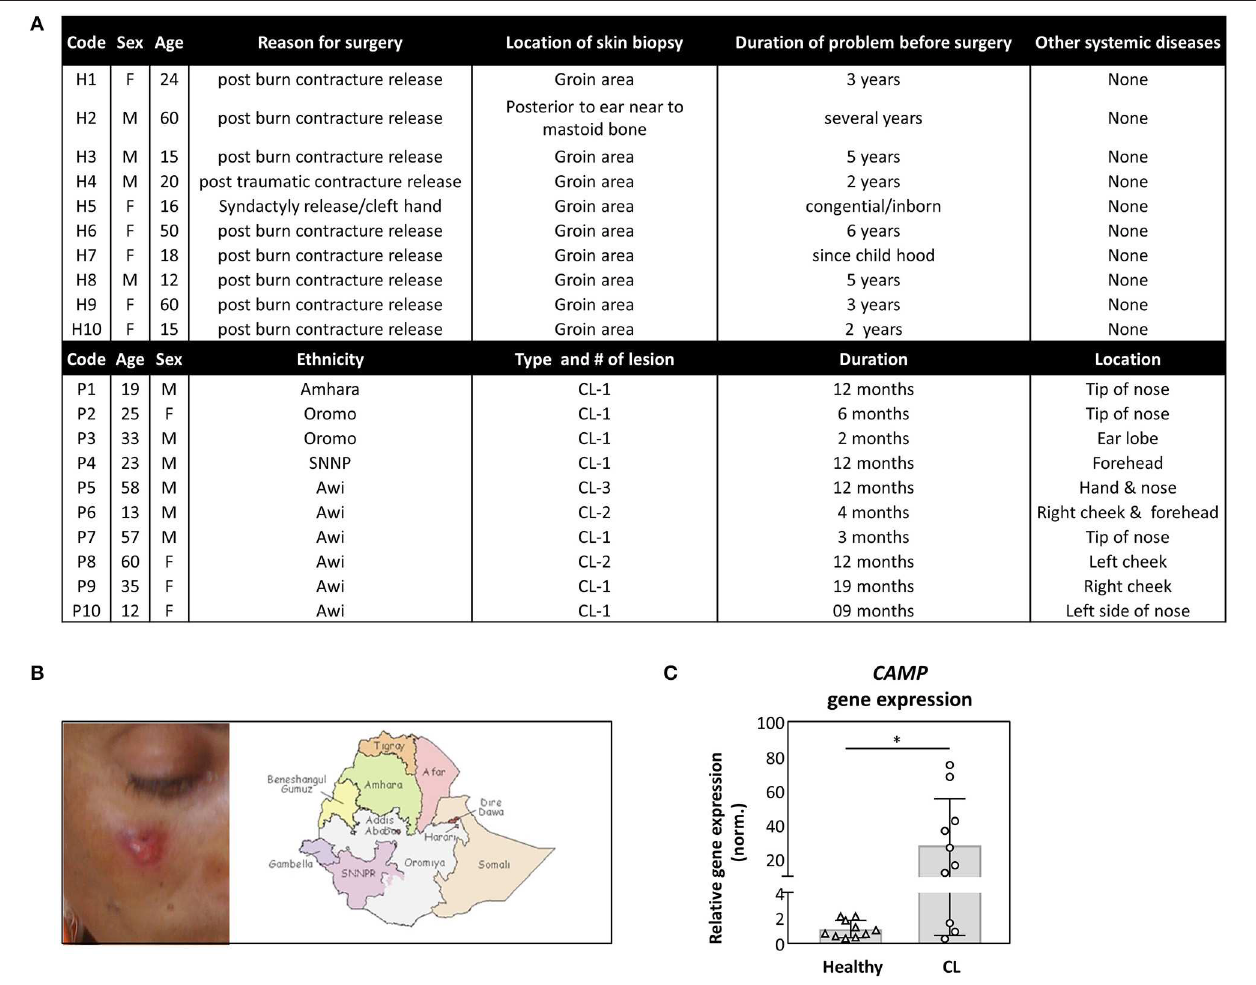
FIGURE 1 | Increased expression of cathelicidin in skin biopsy of patients with cutaneous Leishmaniasis (CL). (A,B) Samples were collected from CL patients, with cutaneous lesions (B) , derived from people with a different ethnicity (A) . (C) Skin biopsies, from healthy ( n = 10) or CL patients ( n = 10), were collected from which CAMP gene expression was assessed by qRT-PCR. Relative gene expression was normalized against GAPDH and presented as mean ± SD. Statistical analysis (Mann–Whitney test) was used to compare groups using GraphPad statistical software (* p < 0.05).